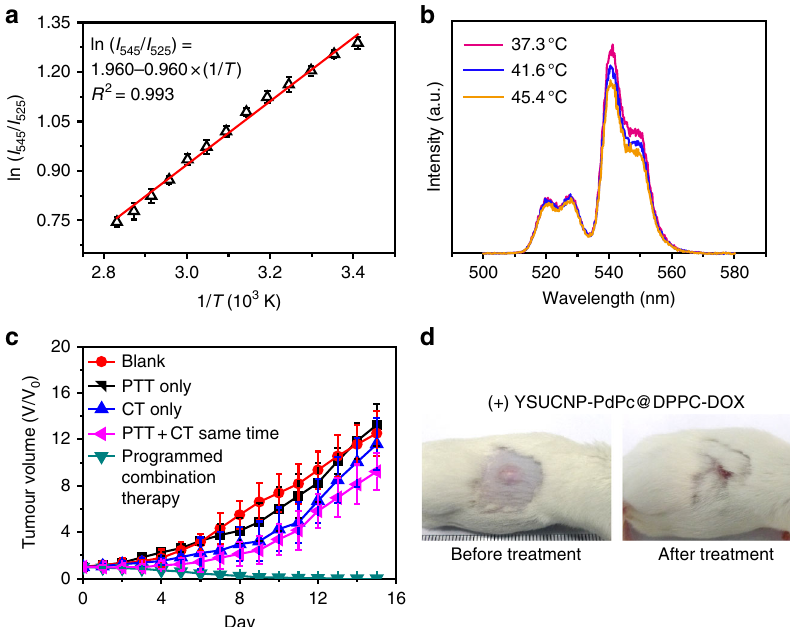
Fig. 7 Eigen temperature sensing and programfmed combination therapy in vivo. a A plot of ln( I 545 / I 525 ) versus 1/ T to calibrate the thermometric scale for TR-UCNS in the tissue phantom. Each point was measured 3 times and the average values were used. Error bars were de fi ned as s.d. ( n = 3). b Upconversion luminescence spectra of TR-UCNS (500 – 580 nm) in tumor-bearing mice detected by fi ber-optic spectrometer under different 730 nm laser power density at 0, 57, and 164 mWcm − 2 . Eigen temperature calculated by the upconversion luminescence spectra were 37.3, 41.6, and 45.4 °C. c Growth of tumors in different groups of mice ( n = 5 in each group) after treatment. The relative tumor volumes were normalized to their initial sizes. Average values of the tumor volume of each group were based on the measurement of the tumors in fi ve mice. Error bars were de fi ned as s.d. ( n = 5). d Representative photos of tumor-bearing mice with programmed combination therapy